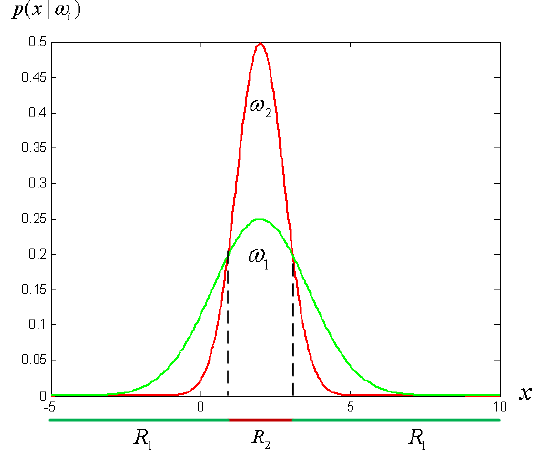
Figure 3. Non-simply connected decision regions in one